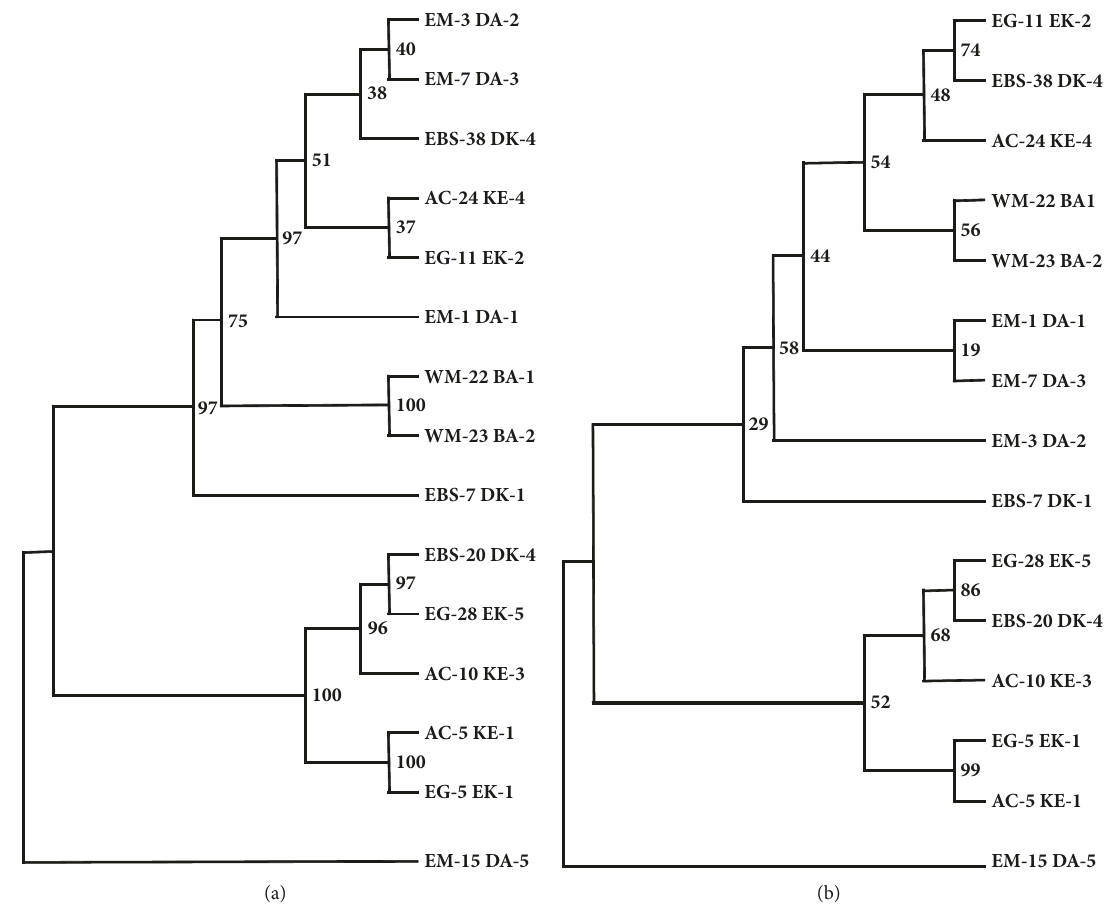
Figure 2: The phylogenetic tree showing genetic relationship among CTV isolates representing different citrus growing regions of Turkey. The phylogenetic tree was constructed with (a) nucleotide and (b) amino acid sequences of the CP gene of Turkish isolates using neighbor joining algorithm in MEGA 6 [35] and tested by a bootstrap analysis with 100 replications. The bootstraps values are shown on nodes of the phylogenetic